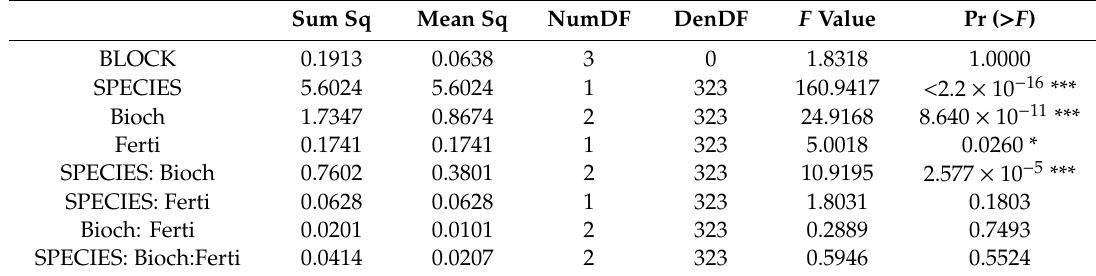
Table A9. Below-Ground Biomass.